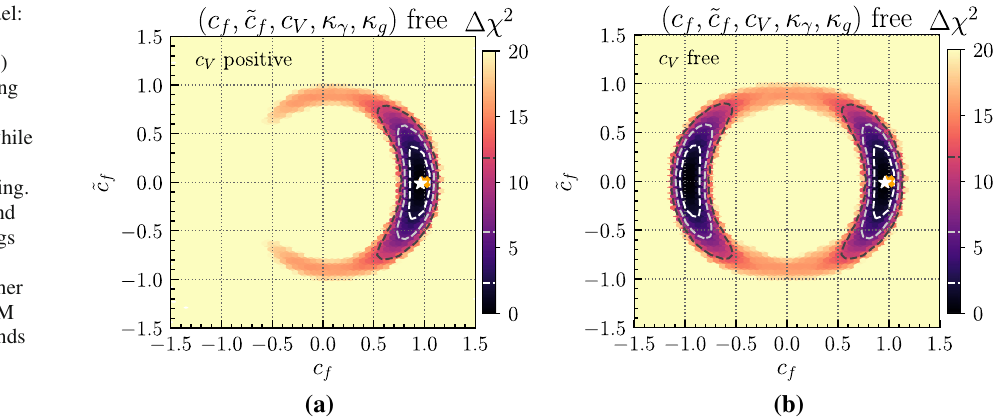
Fig. 8 Fermion-vector model: results of fits to the LHC measurements in the ( c f , ˜ c f ) parameter plane. The coupling modifiers c f , ˜ c f , κ γ , κ g are free-floating in both plots, while a c V is restricted to positive values and b c V is free-floating. In each case, the CP -even and CP -odd parts of the couplings shown in the plot are free-floating while all the other parameters are set to their SM values. The legend corresponds to the one in Fig.